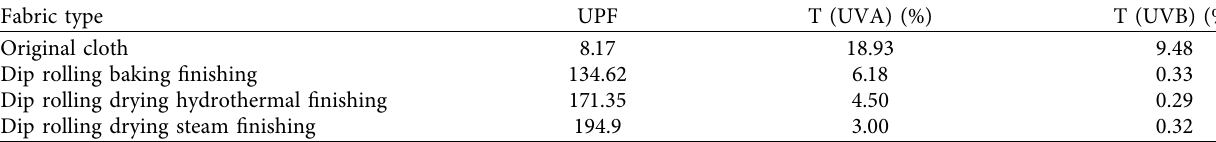
Table 2: UV protection factor table of different fabrics.